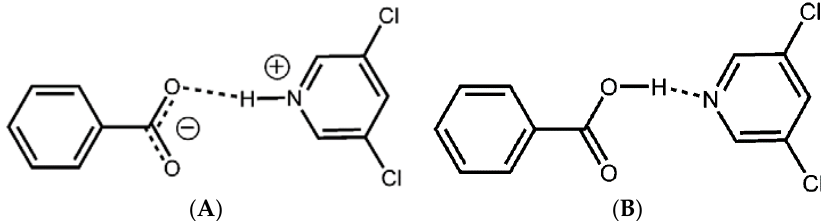
Figure 4. Schematic representation of difference between ( A ) a salt and ( B ) a cocrystal [Reprinted from [91] with permission. Copyright 2007 American Chemical Society].